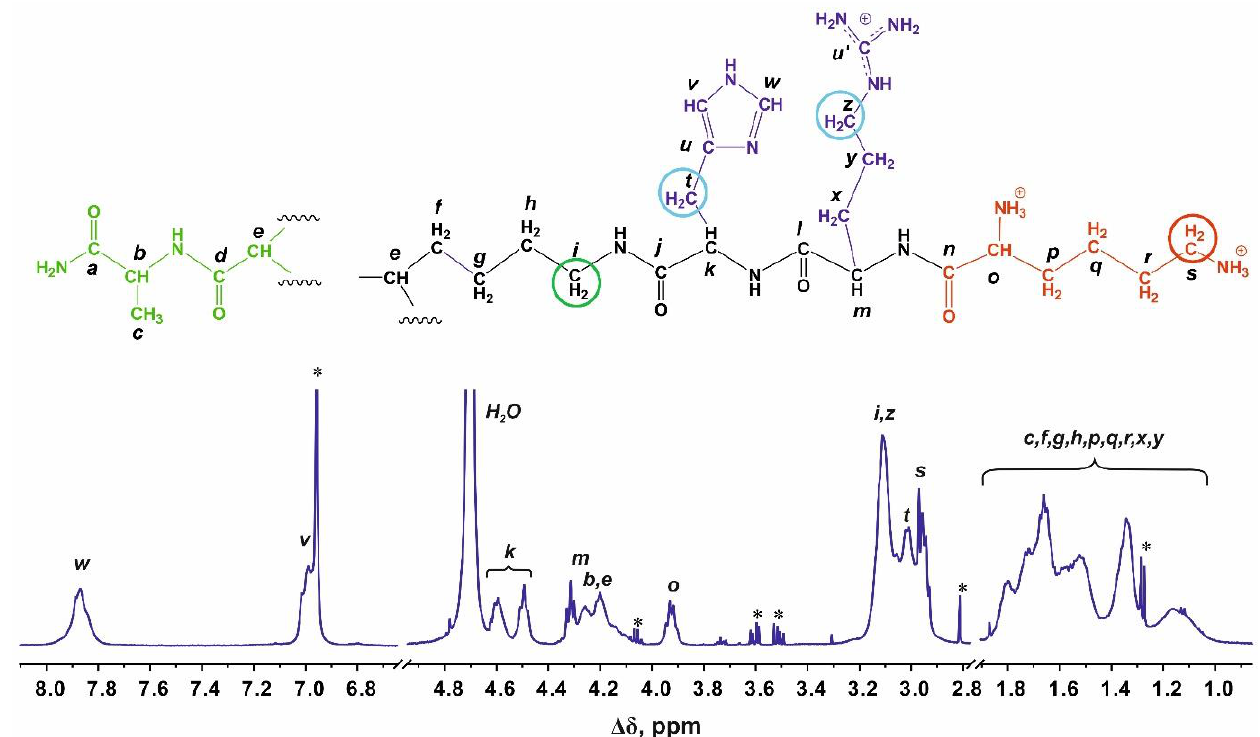
Figure 3. 1 H NMR spectrum of the Lys-His-Arg dendrimer at 298 K. Three types of methylene groups connected with nitrogen atoms (or imidazole rings in His residues), which have been used in NMR relaxation study: inner groups (green open circle), side groups (blue circles) and terminal groups (red circle). The peaks from small molecular weight impurities are marked by asterix (*).